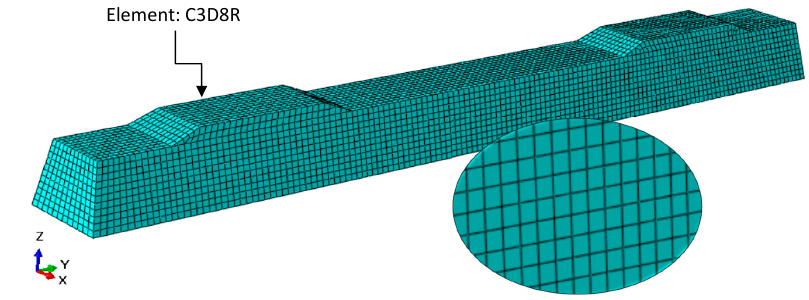
Figure 12. Boundary conditions adopted in the numerical model.